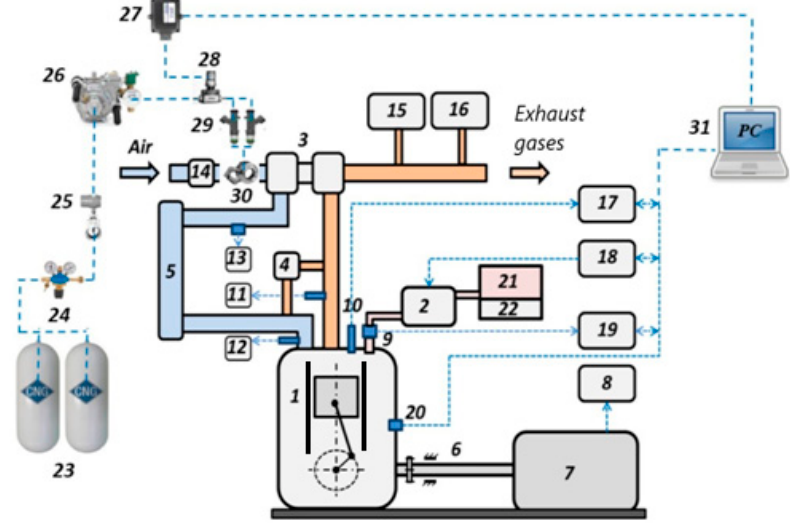
Figure 1. Scheme of the engine testing equipment: 1: engine; 2: high-pressure fuel pump; 3: turbocharger;